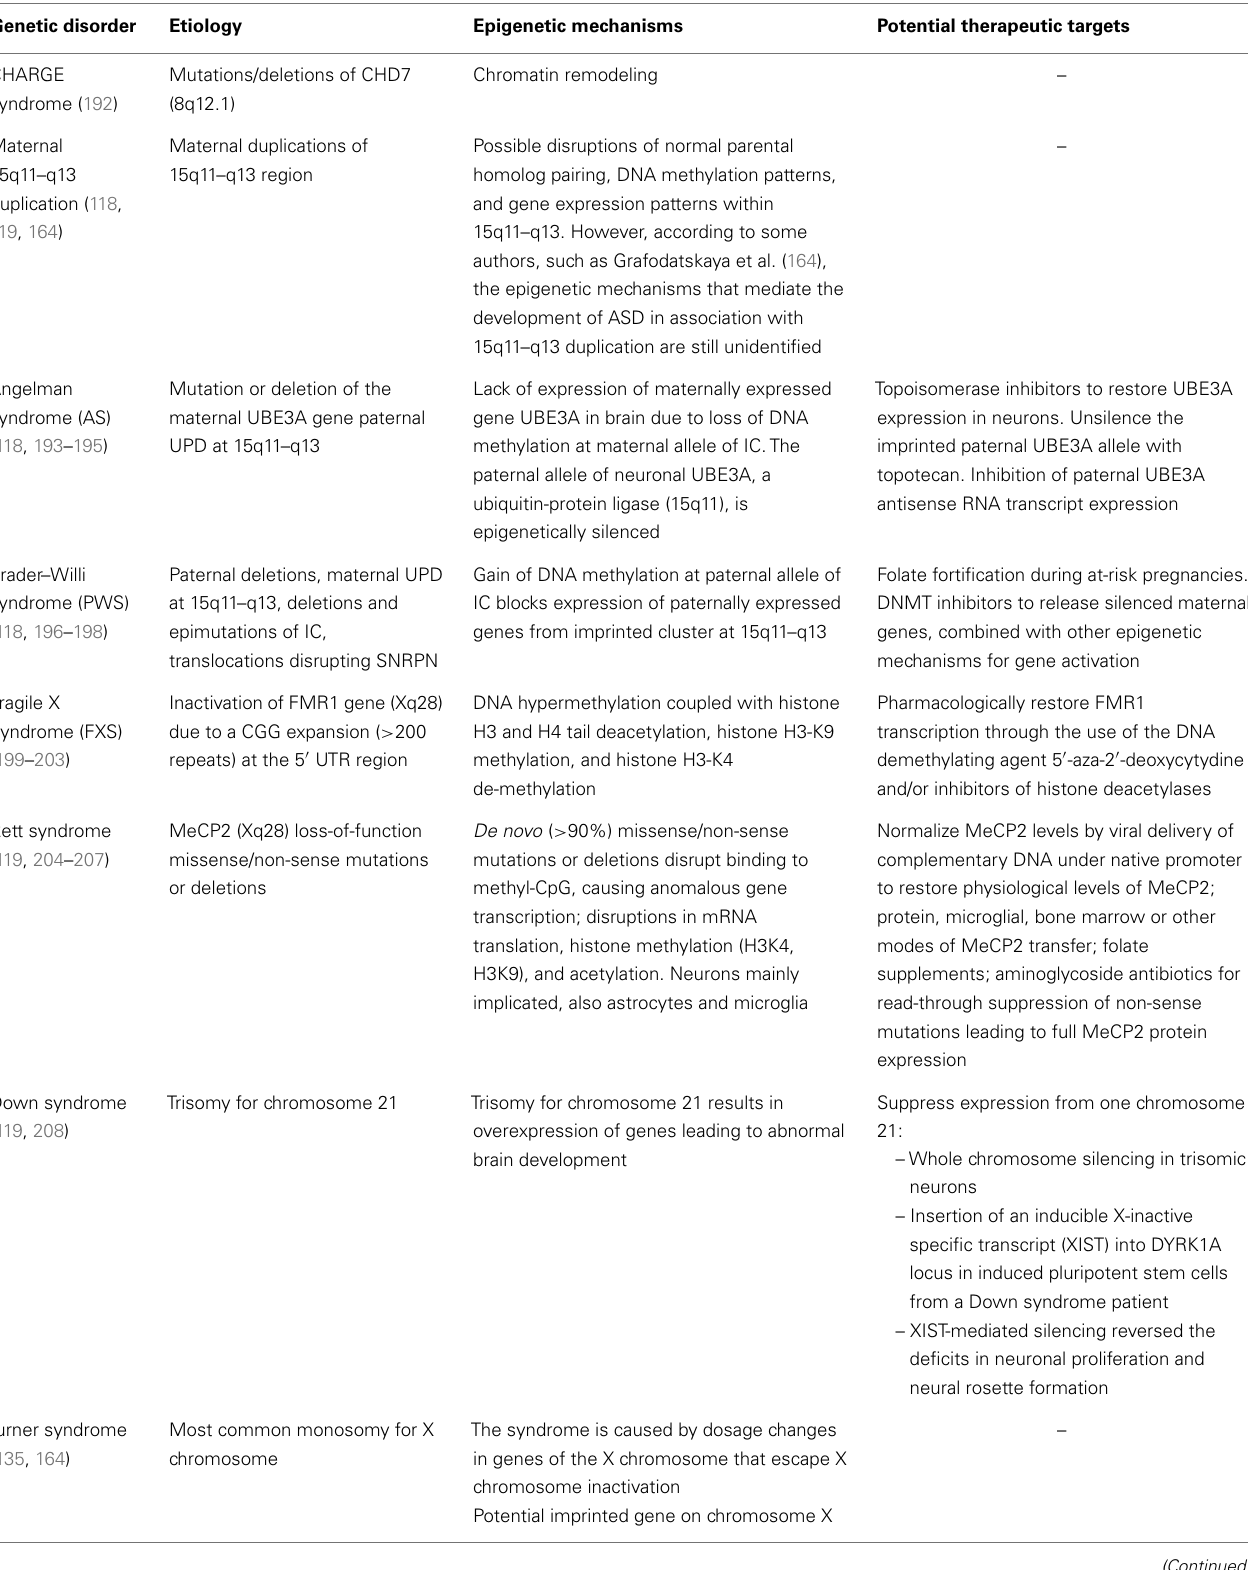
Table 3 | Epigenetic mechanisms and potential therapeutic targets in genetic disorders associated with autistic syndrome